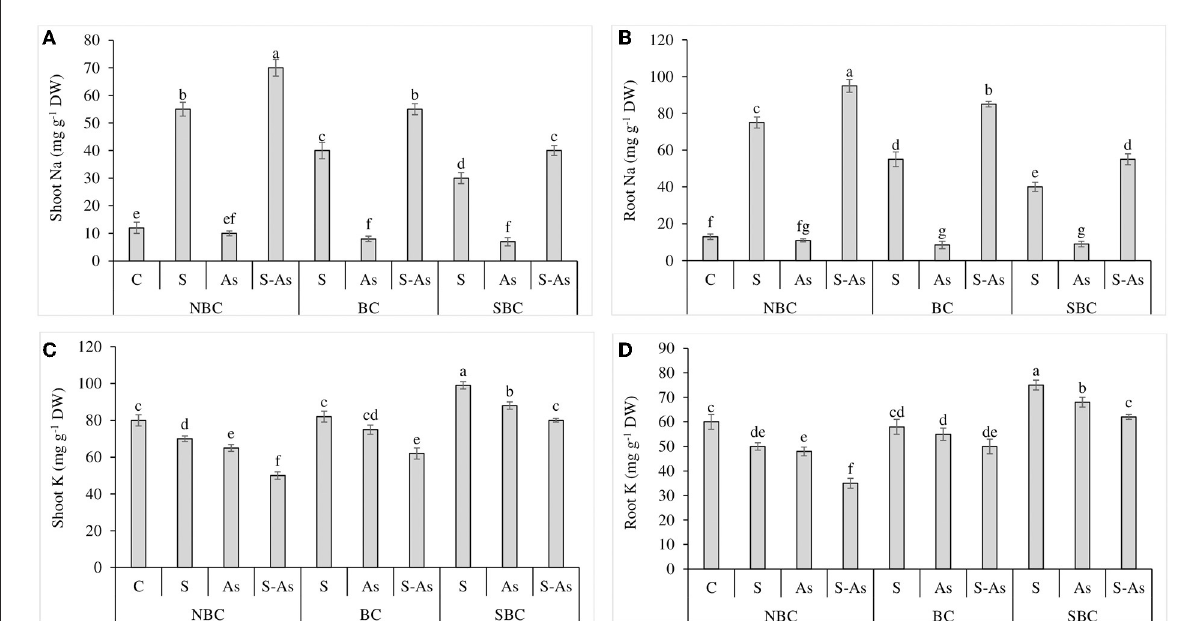
FIGURE1 Effect of salinity, arsenic, and their combination on shoot Na (A) , root Na (B) , shoot K (C) , and root K concentration (D) of quinoa supplemented with no biochar (NBC), biochar (BC), and silicon-nanoparticles doped biochar (SBC). The values (average ± SE of four replicates) followed by different letters represent the significant difference at a significance level of